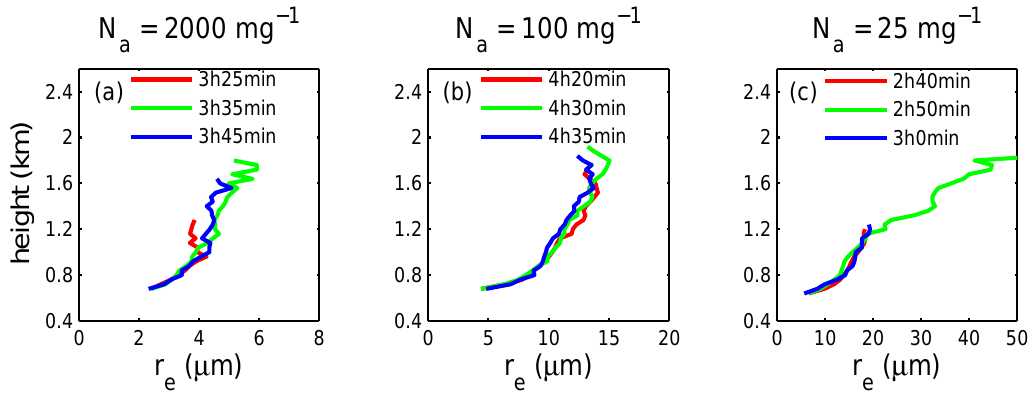
Fig. 3. Evolution of r e profiles of individual clouds throughout their lifetime in each case. (a) A cloud in the polluted case evolving from 3h 15min to 3h 55min. The cloud reaches the maximum height at 3h 35min. (b) A cloud in the intermediate case from 4h 10min to 4h 35min, reaching the maximum height at 4h 30min. (c) A cloud in the clean case from 2h 30min to 3h 5min. It reaches the maximum height at 2h 50min. Only the r e profile at the time with the maximum height, and two profiles before and after the maximum height are